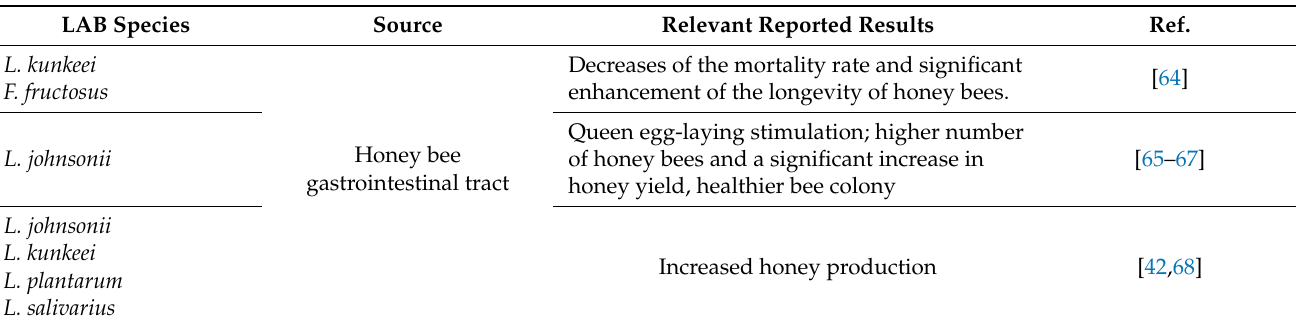
Table 1. Overview of the main results obtained using LABs as probiotics in the honey bee diet. LAB